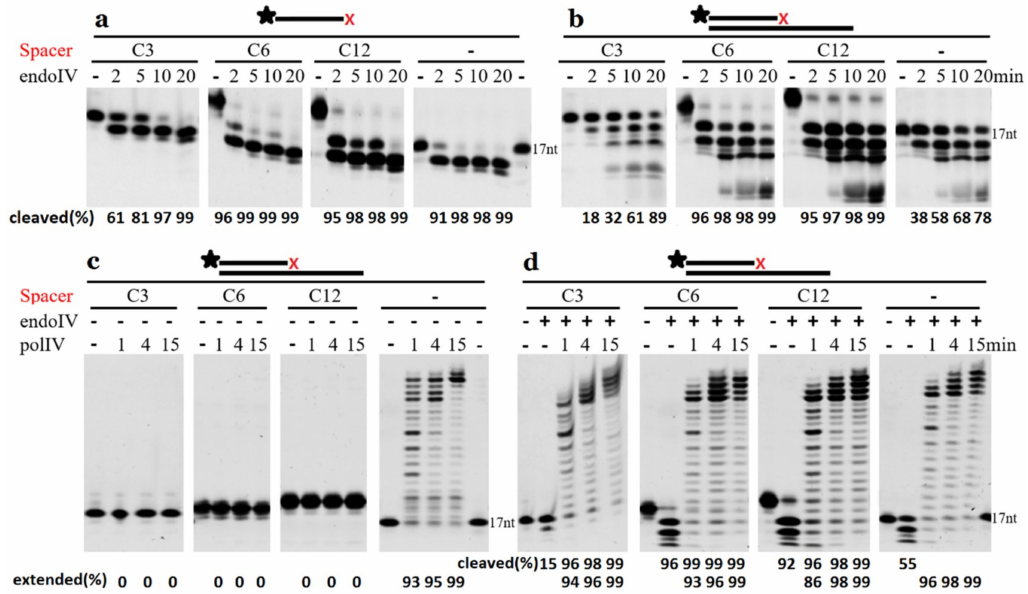
Figure 7. Extension by DNA polymerase after removal of 3 (cid:48) -terminal AP site analogues. ( a )